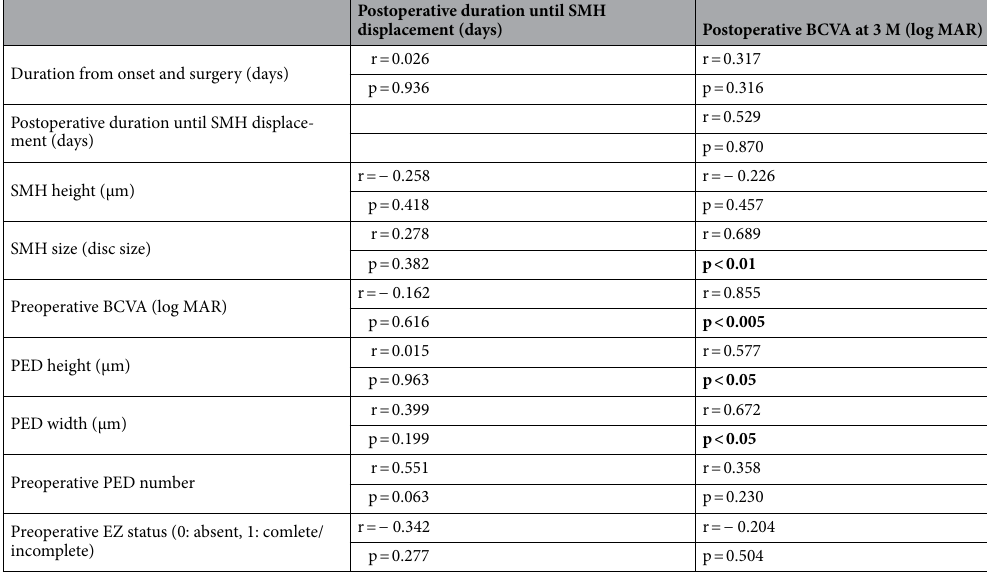
Table 4. Correlation analysis of parameters associated with postoperative duration until SMH displacement and postoperative BCVA at 3 months post-surgery. Significant values are given in bold.